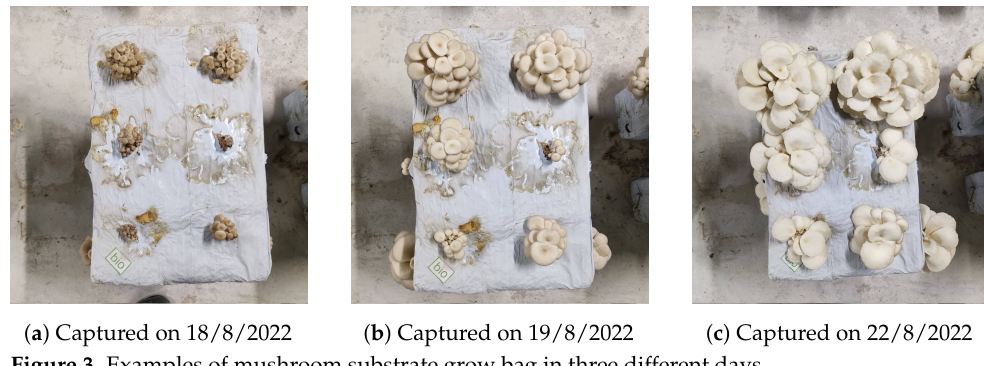
Figure 3. Examples of mushroom substrate grow bag in three different